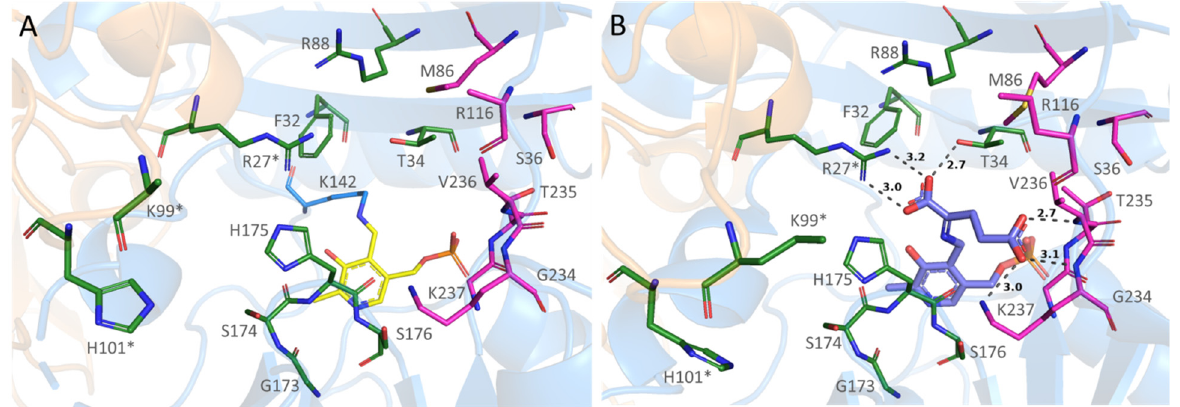
Figure 4. The active site of AmicoTA in ( A ) the holoenzyme with PLP bound to K142, ( B) in the complex with D-glutamate. Both subunits are shown in cartoon mode: first—in light blue, second— in light orange. Residues of the O-pocket are shown in green, of the P-pocket—in magenta, the PLP molecule is shown in yellow, and the ketimine formed by PLP and D-glutamate is in purple. (*) indicates residues from the adjacent subunit of the functional dimer. Distances are given in Å and depicted with dashed lines.